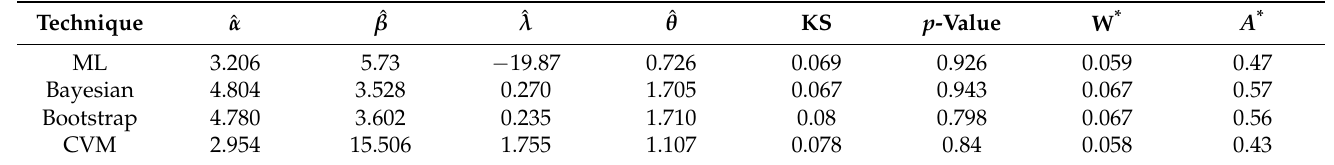
Table 8. The estimated parameters, KS, p -values, W ∗ , and A ∗ for all estimation techniques using the 2nd